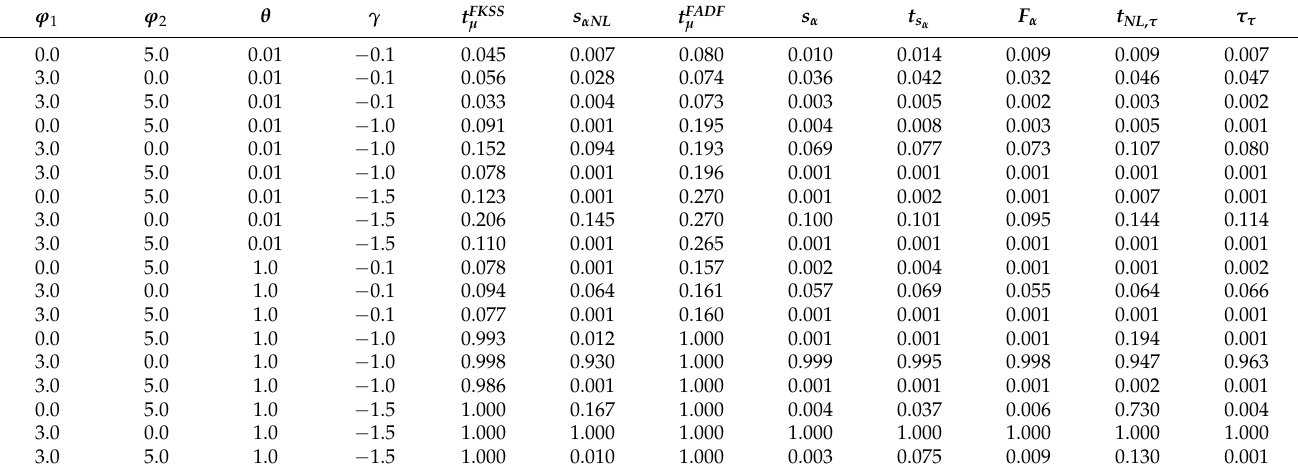
Table 2. The simulated powers of alternative tests under the